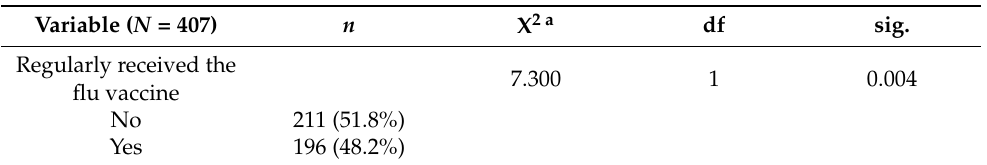
Figure 5. Factors that drive the refusal of COVID-19 vaccines. Table 3. A chi-square test of independence between the acceptability of the COVID-19 vaccine and the regularly received the flu vaccine variable.